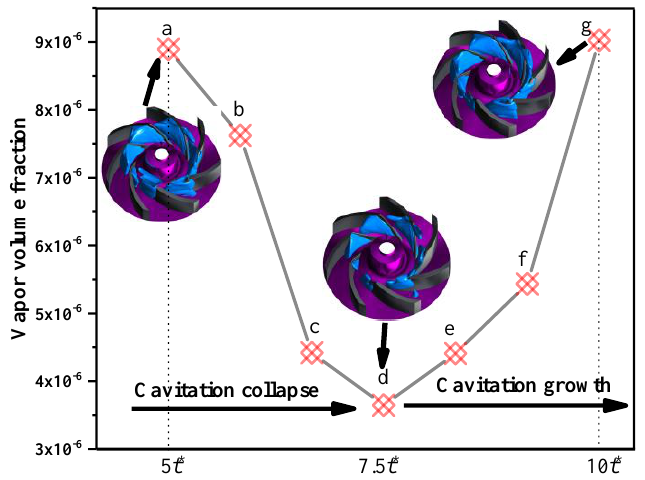
Figure 18. Unsteady process of vapor volume fraction.